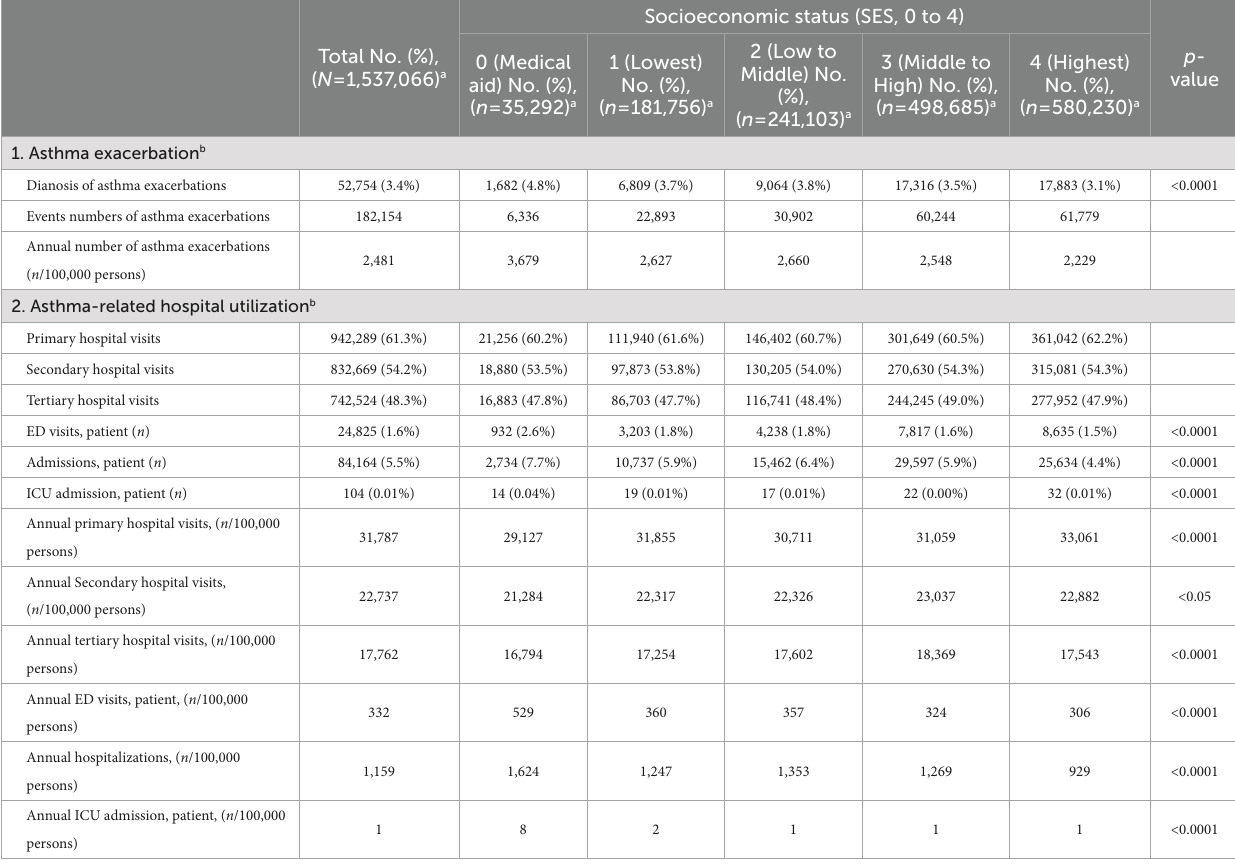
TABLE 2 Asthma exacerbation, utilization of or admissions to medical institutions, and medical costs due to childhood asthma ( ≥ 2 and < 19 years of age). Socioeconomic status (SES, 0 to Total No. (%), ( N = 1,537,066) a